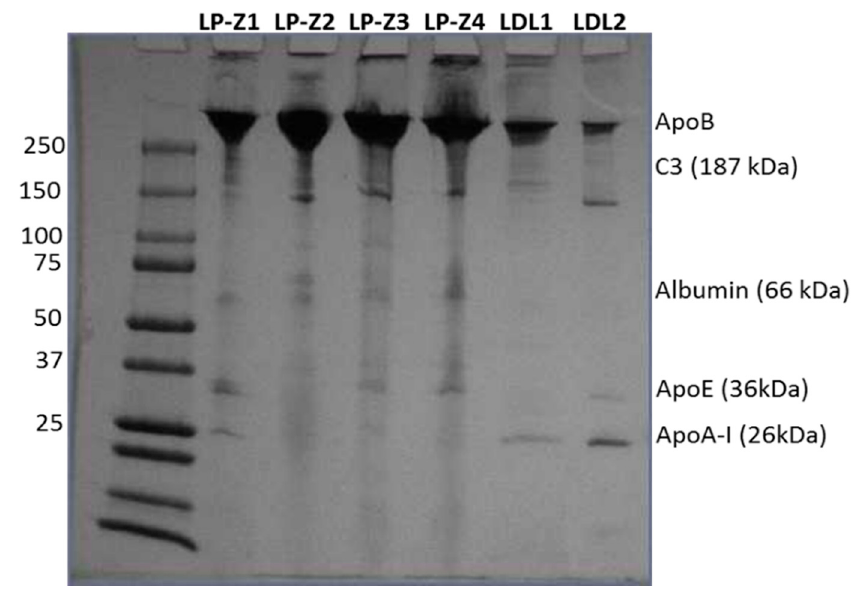
Figure 7. Polyacrylamide gel electrophoresis of isolated LP-Z (LP-Z1–Z4) and LDL (LDL1, LDL2) particles.